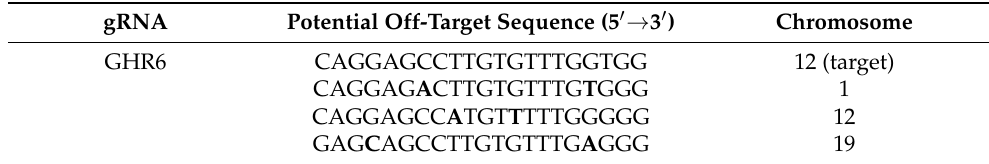
Table 2. Potential off-targets of the GHR6 gRNA in the Hd-rR genome. gRNA Potential Off-Target Sequence (5 (cid:48) → 3 (cid:48) )